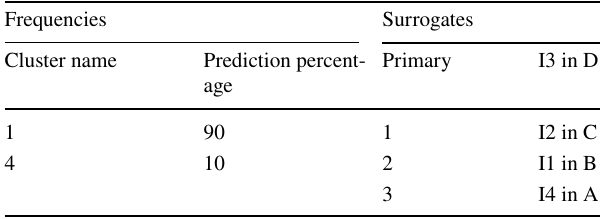
Table 14 Frequencies and surrogates data of D in I3 Frequencies